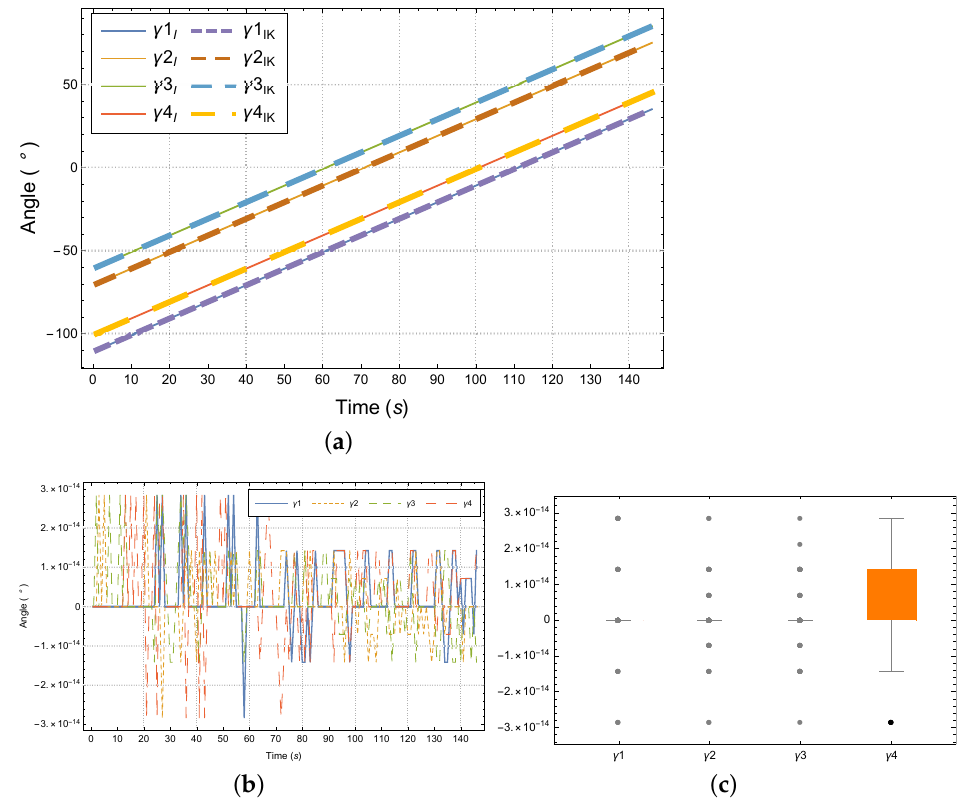
Figure 10. A comparison of the mathematical models of the inverse kinematics. ( a ) Comparison of the inverse kinematics ( γ 1 , γ 2 , γ 3 , γ 4 ) between CAD mechanical design and inverse kinematics equations. ( b ) Mean Square Error of the inverse kinematics. ( c ) Box plot of the inverse